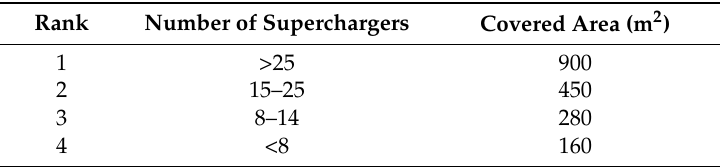
Table 8. Level specifications of charging stations.